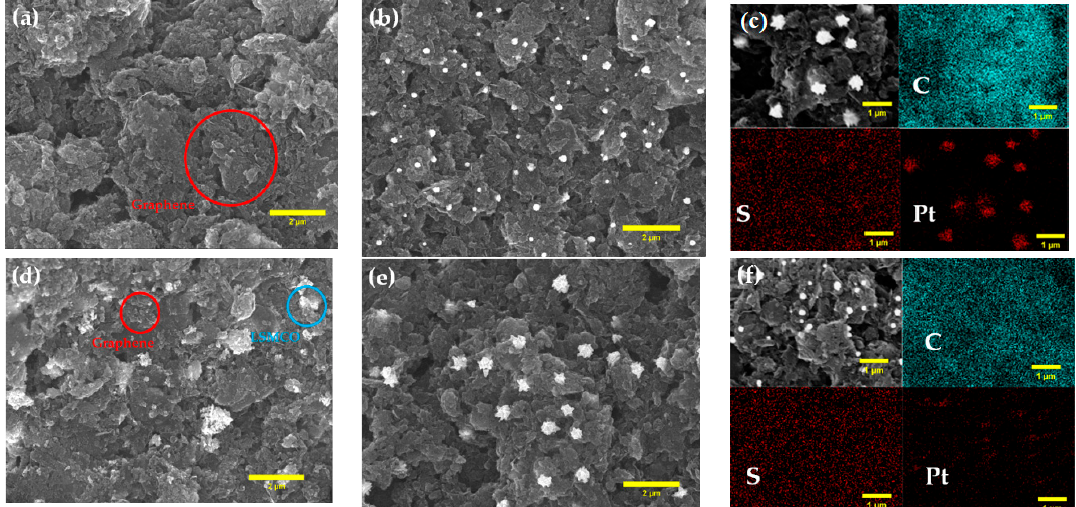
Figure 1. SEM images of as-prepared ( a ) electrode of G95 before cyclic voltammetry; ( b ) after cyclic voltammetry 5000 cycles; ( c ) SEM image of G95 with EDX mapping of C, S, and Pt; ( d ) electrode of G70L25 before cyclic voltammetry and ( e ) after cyclic voltammetry 5000 cycles; ( f ) SEM image of G70L25 with EDX mapping of C, S, and Pt.